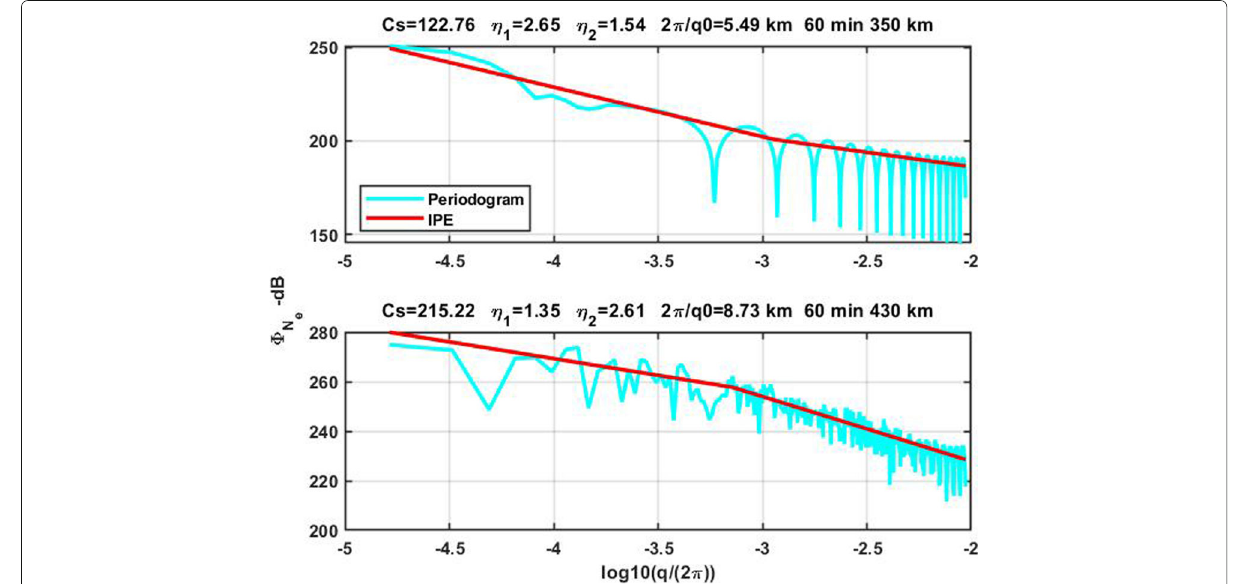
Fig. 11 SDFs (magenta) with overlaid theoretical SDFs from IPE parameters (red)